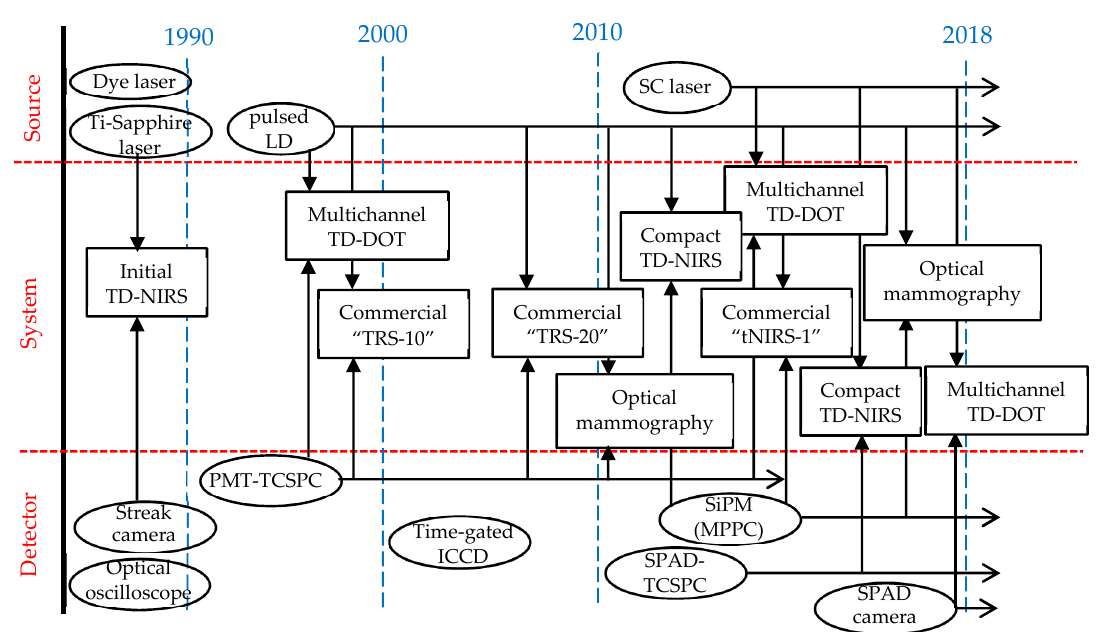
Figure 19. Schematic view of the chronological development of the TD-NIRS instruments classifying the sources, detectors, and systems, indicating incorporation of the sources and detectors into the systems by vertical arrows (abbreviation: pLD—pulsed laser diode).